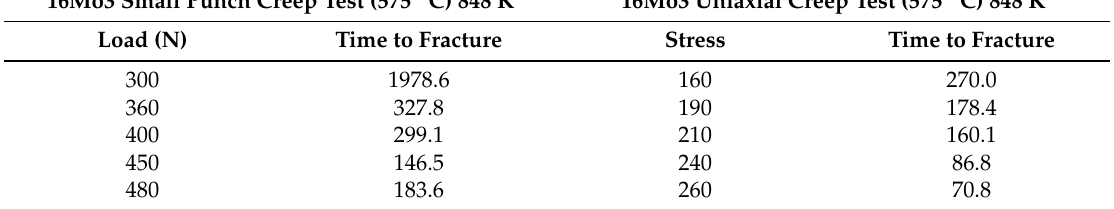
Table 2. The fracture time of the small punch test and the uniaxial creep test under each loading condition.